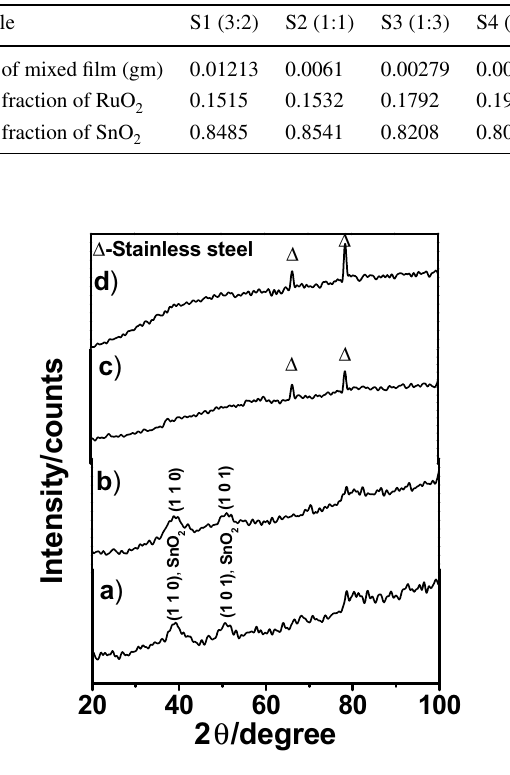
Fig. 2 The X-ray diffraction patterns of SnO 2 –RuO 2 mixed films for samples a S1 (SnO 2 :RuO 2 , 3:2), b S2 (1:1), c S3 (3:1) and d S4